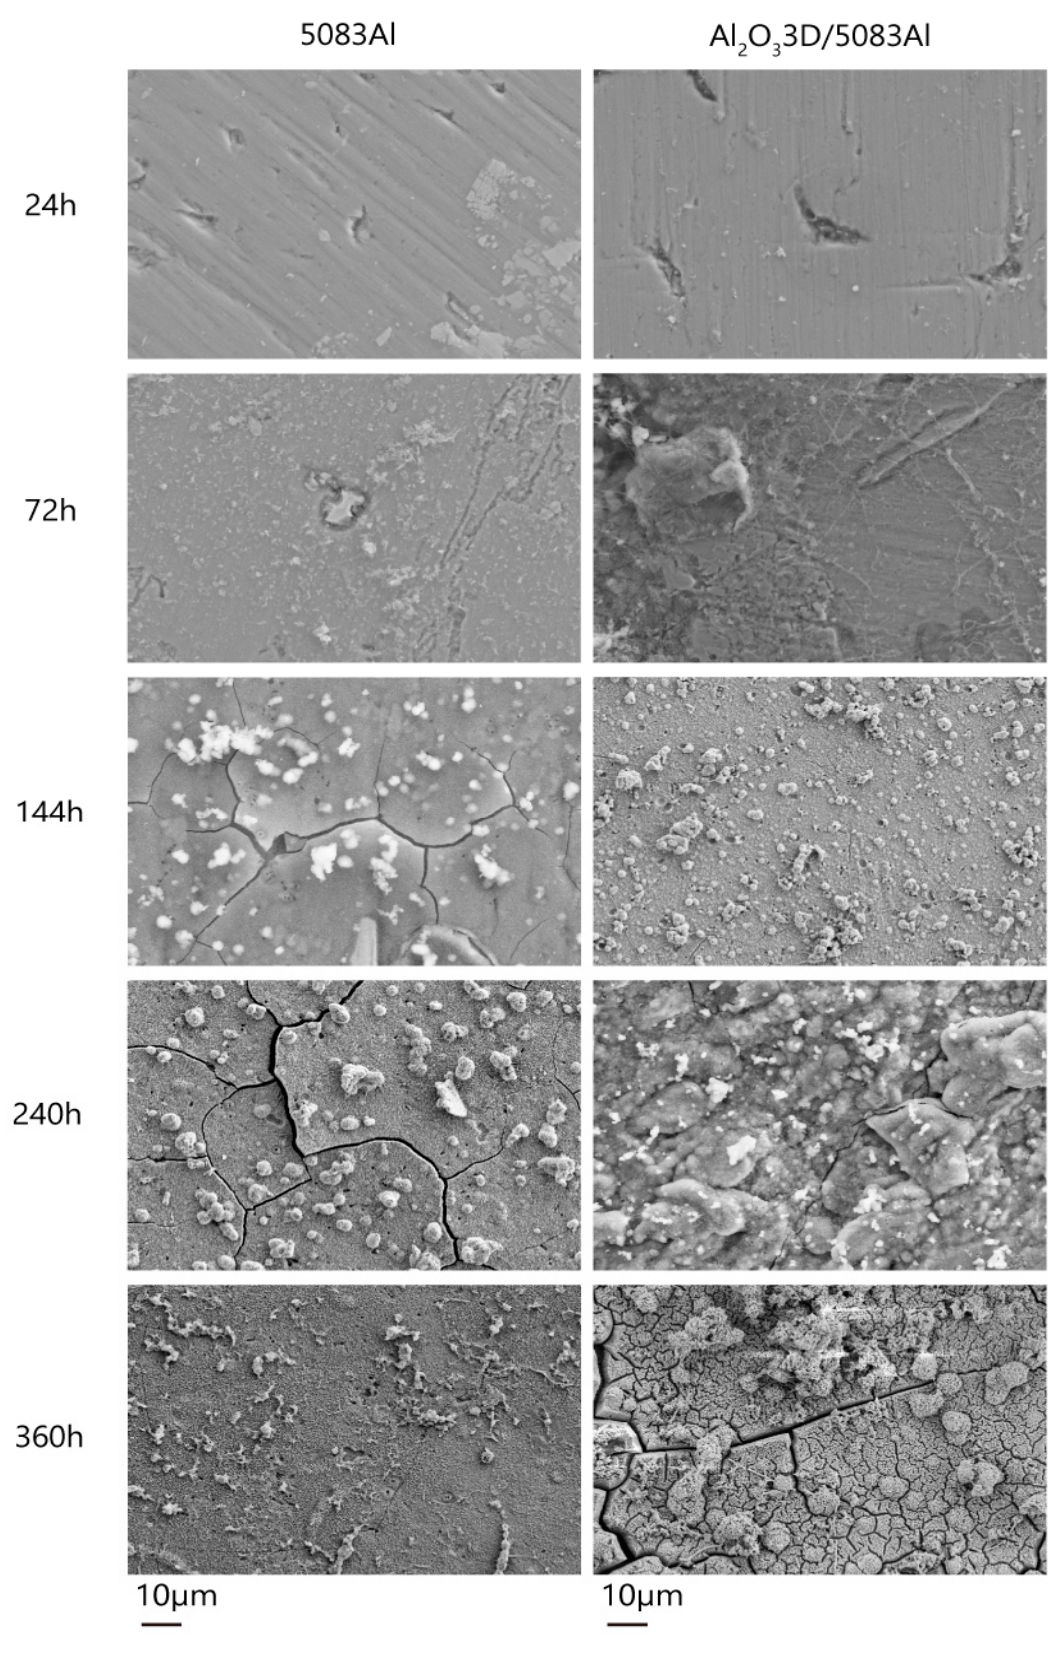
Figure 8. Corrosion product morphology under different times after NSS corrosion.